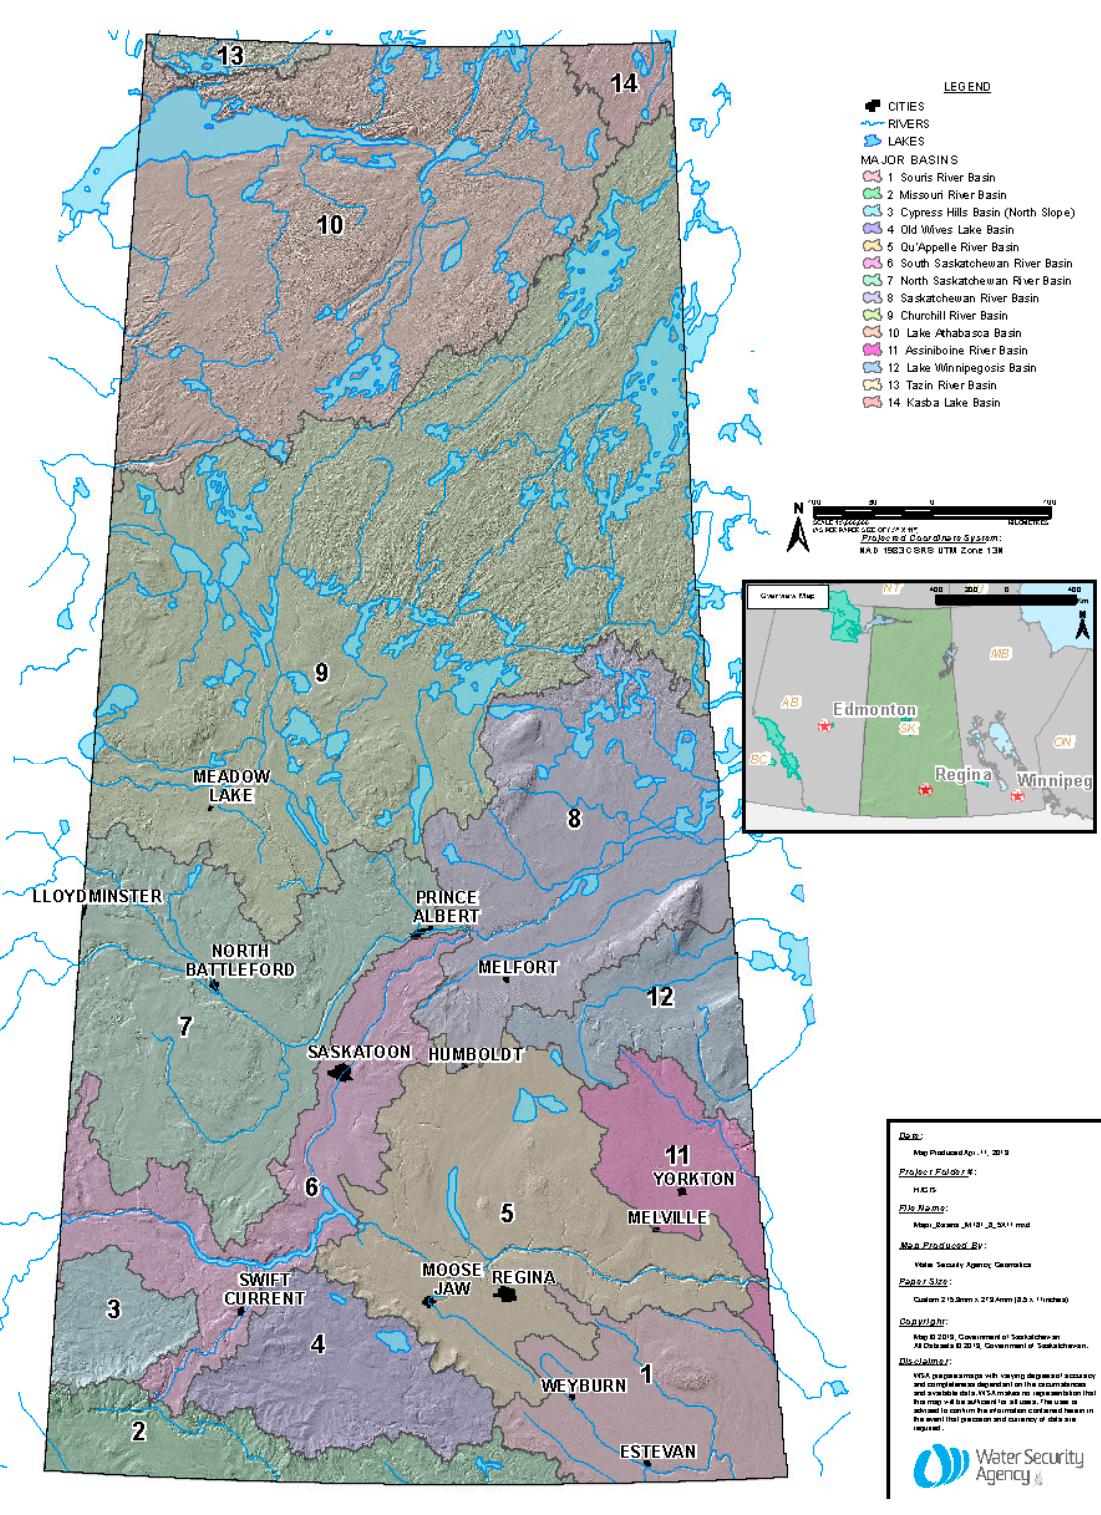
Figure 1. Map of Saskatchewan watersheds and water bodies